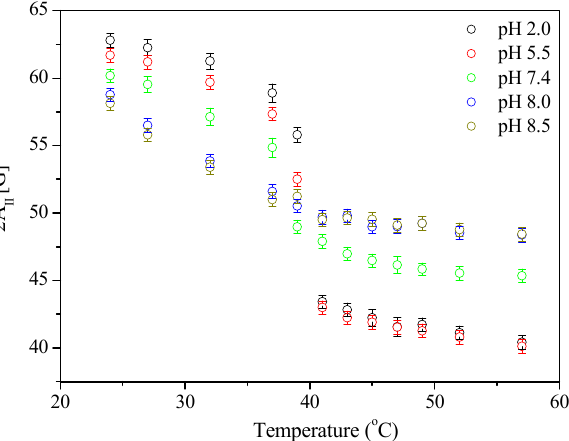
Figure 6. Effect of the temperature on maximum hyperfine splitting 2A II of 5-DOXYL in liposome vesicles.